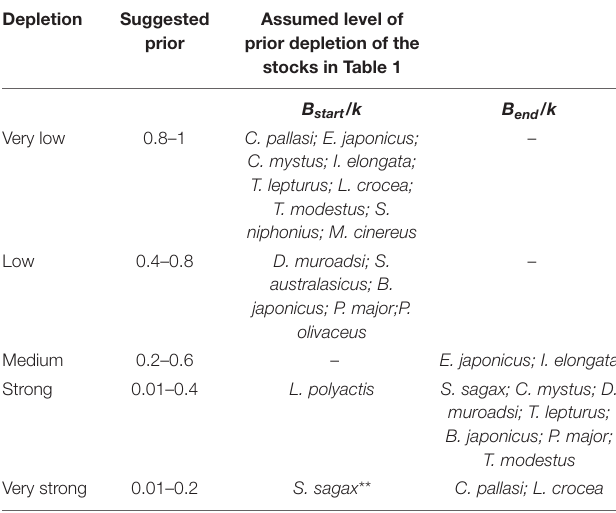
TABLE 3 | Suggested ranges of the fraction B start / k and B end /k for the biomass depletion before catch data are available*. Depletion